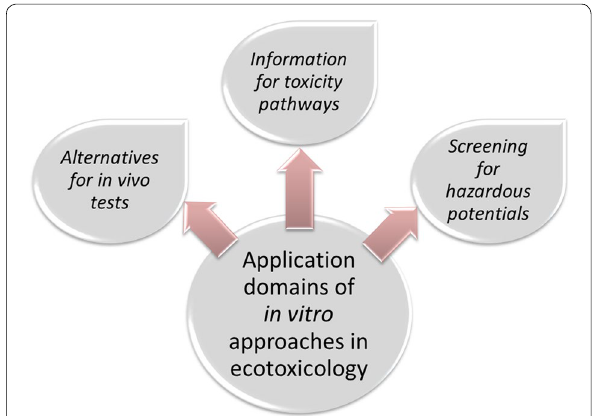
Fig. 1 Examples for in vitro applications in ecotoxicology: In vitro approaches are widely used as alternative for in vivo tests in the sense of the 3Rs (replacement, reduction and refinement), to study toxic mechanisms at molecular and cellular levels and for screening of compounds or environmental samples for hazardous